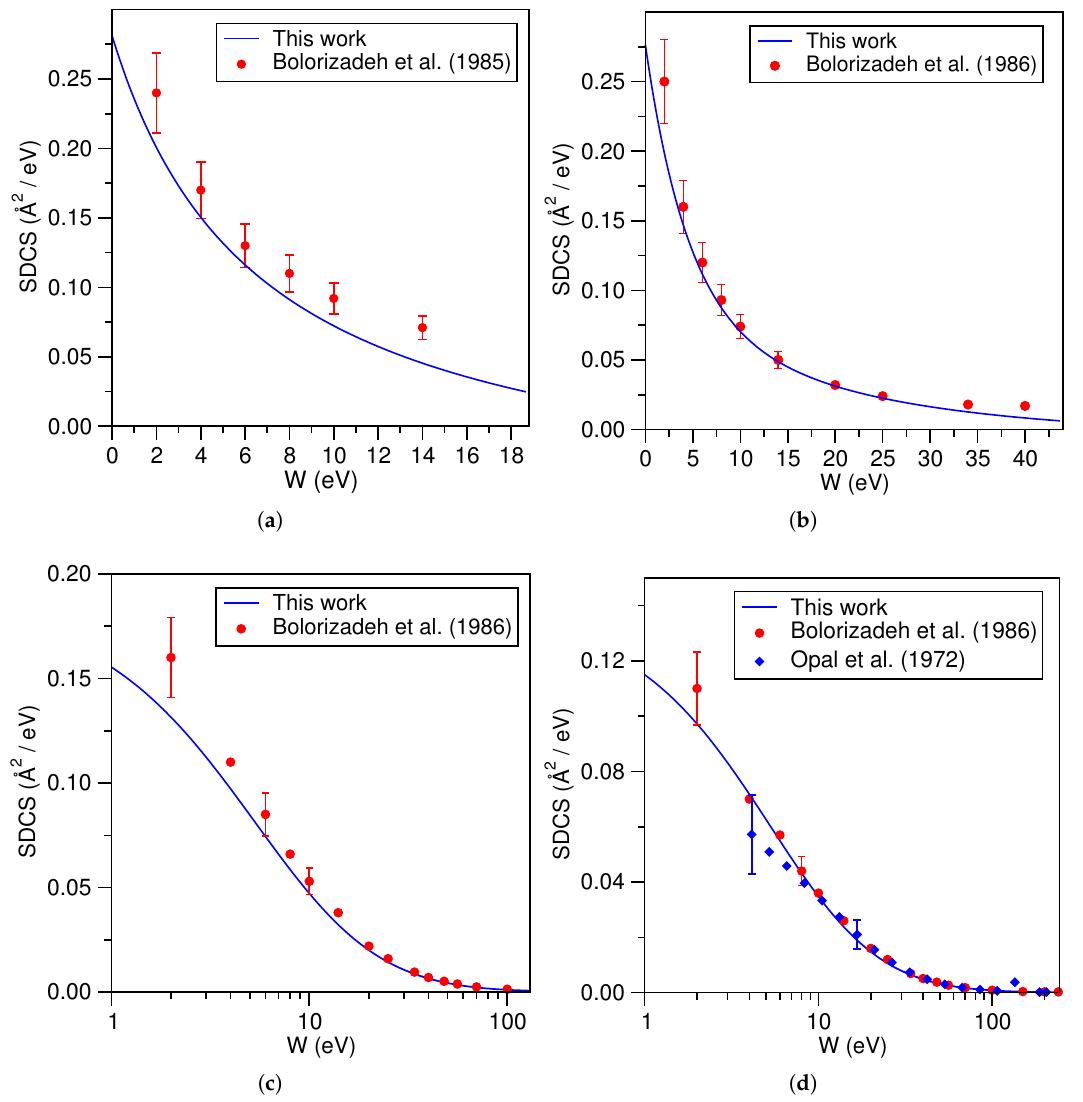
Figure 6. Electron-impact SDCS for H 2 O at a primary electron energy of ( a ) T = 50 eV, ( b ) T = 100 eV, ( c ) T = 200 eV, and ( d ) T = 500 eV. The solid lines represent the present results, the filled circles are the experimental measurements of Bolorizadeh et al. [45], and the filled quadrilaterals are the experimental measurements of Opal et al.